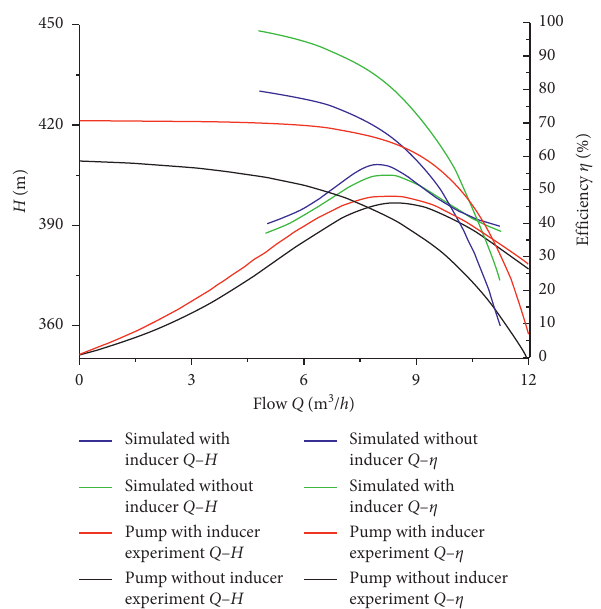
Figure 18: Comparison of experimental and simulation